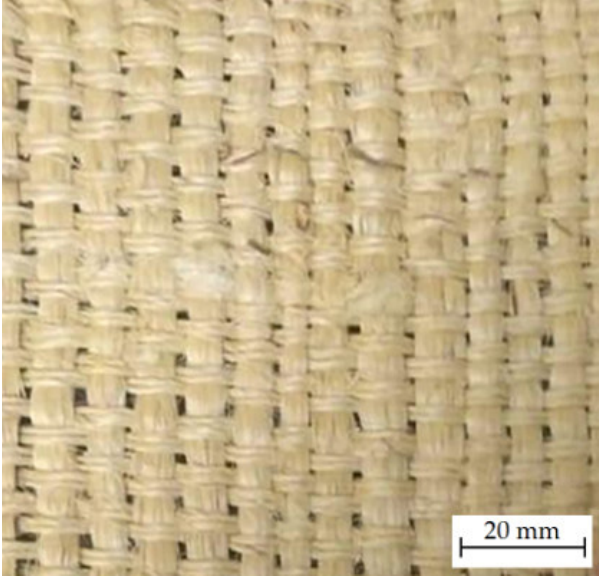
Figure 1. Fique fabric plain woven.